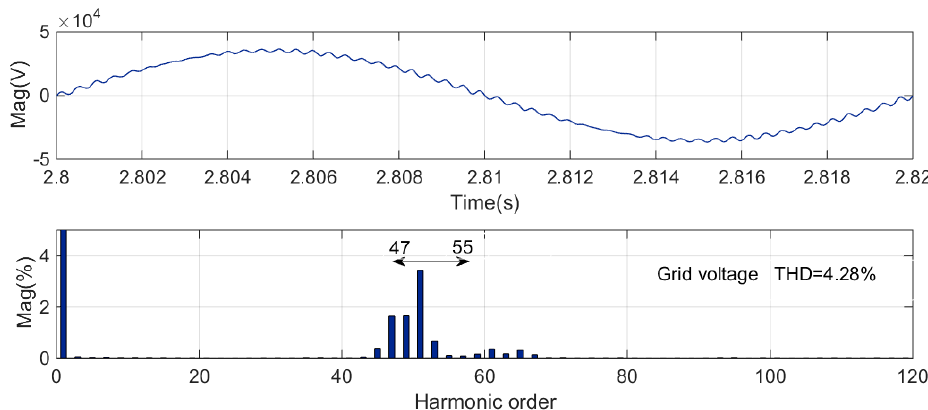
Figure 22. Waveform and FFT analysis of grid voltage.